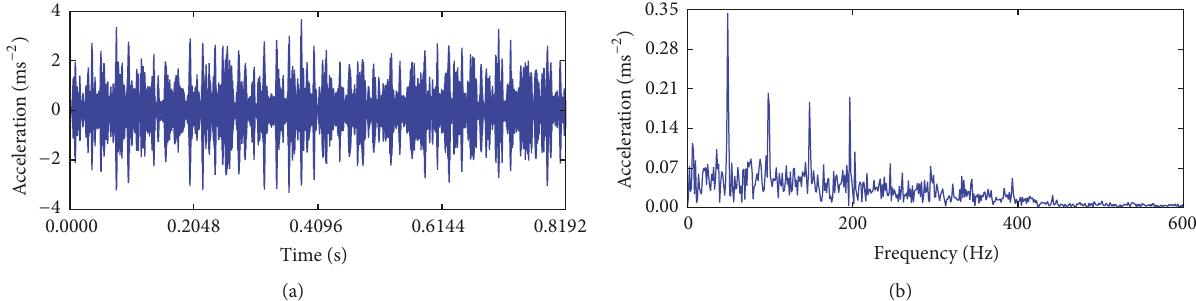
Figure 7: The results obtained by filtering-based demodulation technique: (a) the filtered signals; (b) Hilbert spectra of filtered signals.